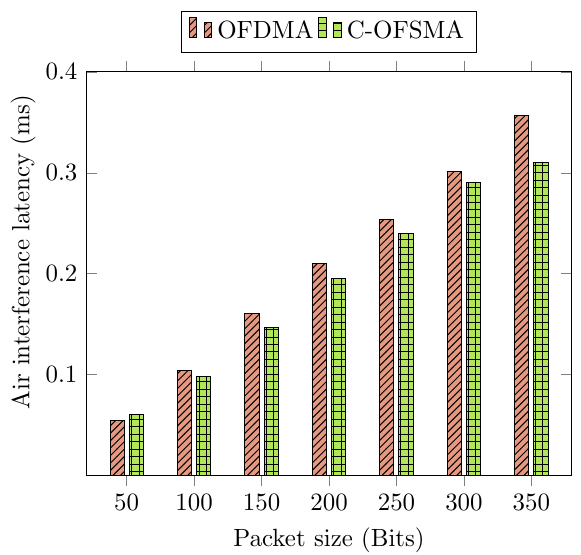
Figure 13. Determine air interference latency in different packet